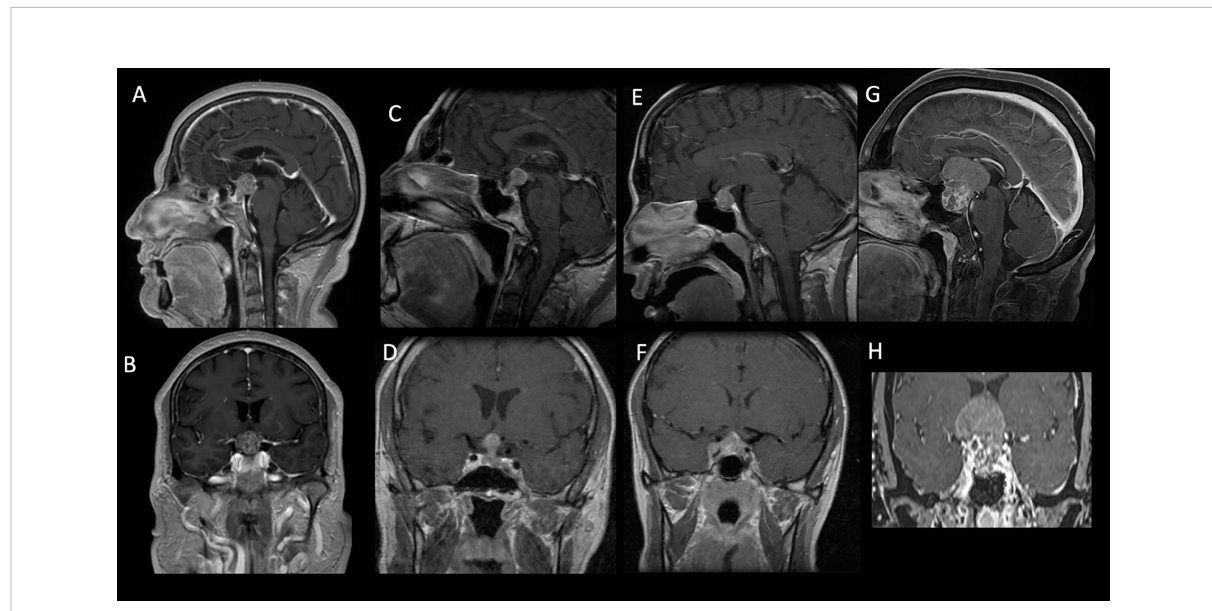
FIGURE 2 Sagittal and coronal preoperative MRI T1-weighted contrast-enhanced images of patients from our cohort showing intra- and suprasellar lesions with inhomogeneous enhancement. The pathology report disclosed breast adenocarcinoma (A , B) , lung adenocarcinoma (C , D) , clear cell renal carcinoma (E , F) , and uterine cervix carcinoma ( G, H